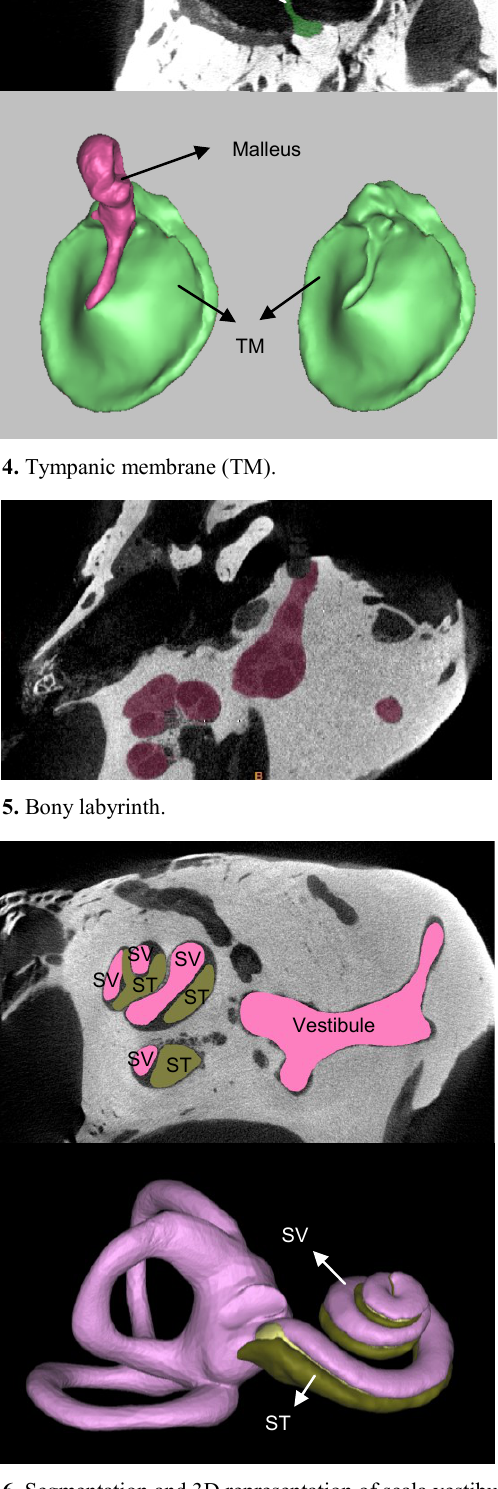
Fig. 6. Segmentation and 3D representation of scala vestibuli and scala tympani.